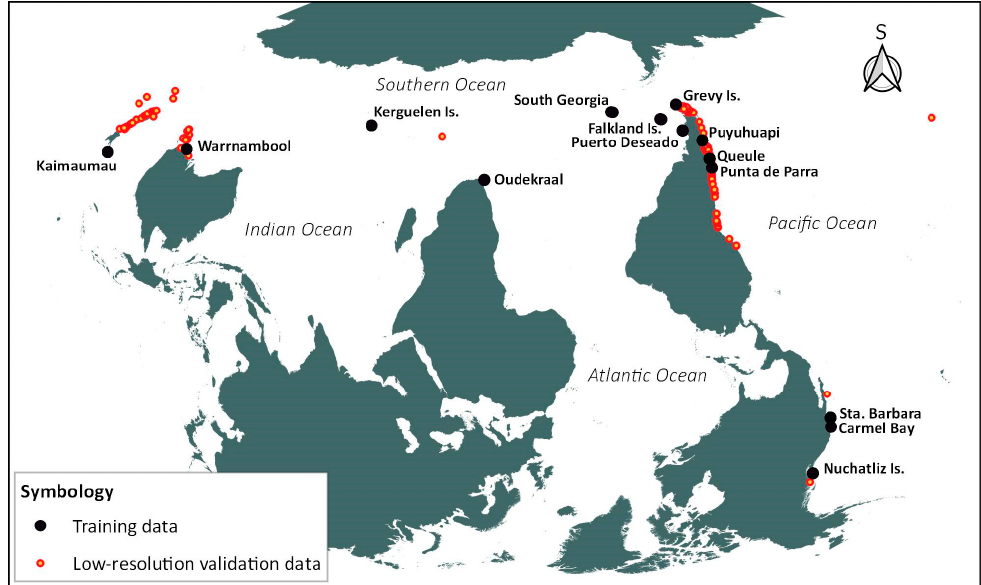
Figure 4. Location of the training data (black dots) and the low-resolution validation sites (red dots). Cartographic projection EPSG: 54042. Maps in this article are south-oriented to highlight the connectivity of giant kelp forests at sub-Antarctic latitudes.